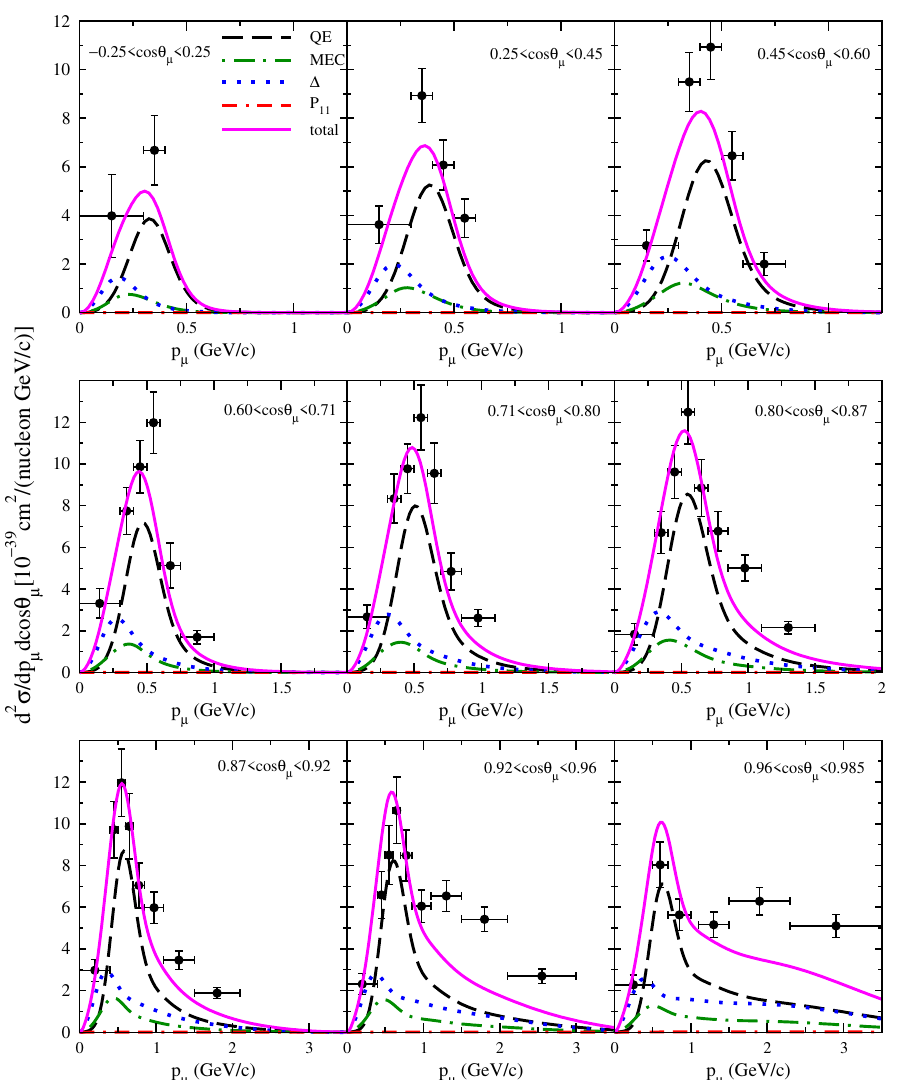
Figure 5. The SuSA inclusive double differential ( ν µ , µ − ) cross-section off 12 C , averaged over the T2K flux, is displayed versus the muon momentum p µ . The separate QE, MEC, ∆ and P 11 contributions are shown. Data from Reference